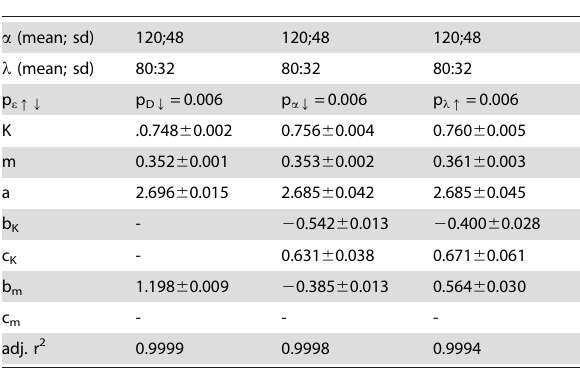
Table 3. Simulation conditions of the responses to an effector as perturbed according to the three modalities that cause response drop, and respective fittings to the model (22).